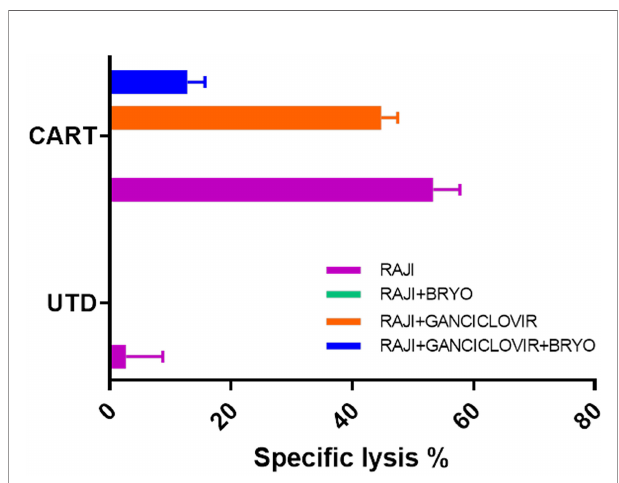
FIGURE 9 | Impact of EBV lytic cycle inhibition on CD22 CAR-T mediated killing of bryostatin-treated Raji leukemia cells. Raji cells were cultured for 2 weeks in the presence or absence of 15 uM ganciclovir (+Ganciclovir in legend), and for the fi nal day of culture bryostatin was added where indicated (+Bryo in legend). Treated cells were then used as targets in CTL assays using anti-CD22 CAR-T (CART) or untransduced T cells (UTD) as effector cells. Average cytolysis of 3 replicate wells is plotted for each condition. Results are representative of three independent experiments.